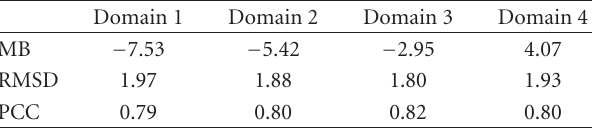
Table 1: Mean Bias (MB), Root Mean Square Di ff erence (RMSD) and Pattern Correlation Coe ffi cient (PCC) for each of the sim- ulation with respect to TRMM over the analyzed domain (e.g., Figure 1(b)). MB is expressed as percentage of TRMM values while RMSD as